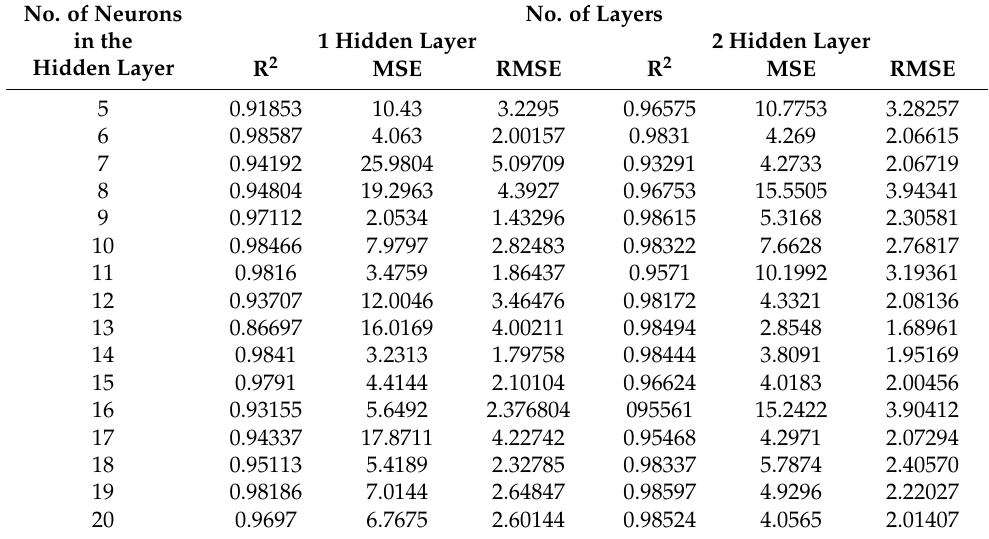
Table 4. Performance evaluation in ANN